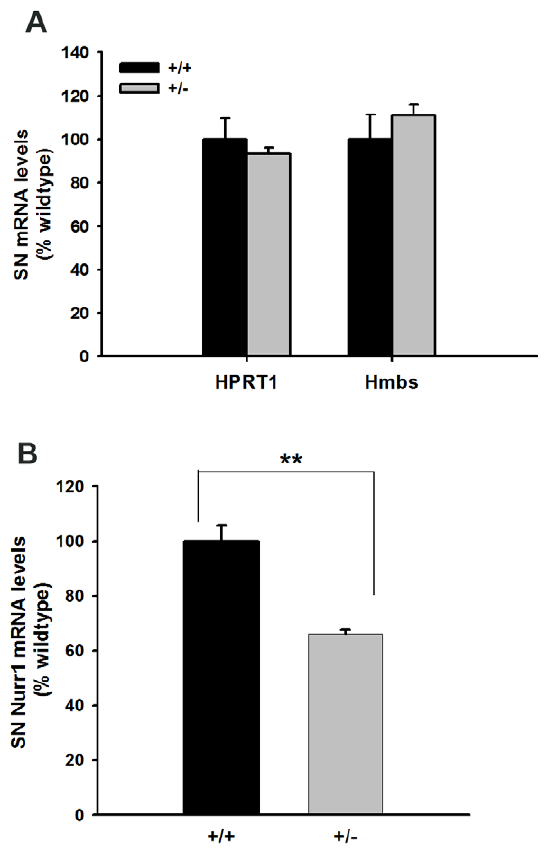
Figure 1. Nurr1 mRNA levels are decreased in the brains of Nurr1 heterozygous mice. Substantia Nigra (SN) mRNA levels for Nurr1, HPRT1 and Hmbs were measured in adult Nurr1 + / + (n=5) and + / 2 mice (n=5) by qRT-PCR. Two housekeeping genes (HPRT1 and Hmbs) did not differ between + / + and + / 2 mice (panel A). For each sample, Nurr1 mRNA levels were normalized to the housekeeping gene Hmbs mRNA levels. Nurr1 mRNA levels are significantly decreased (66% of wildtype) in + / 2 mice compared to levels in + / + mice (**p , 0.005, Student’s t-test).